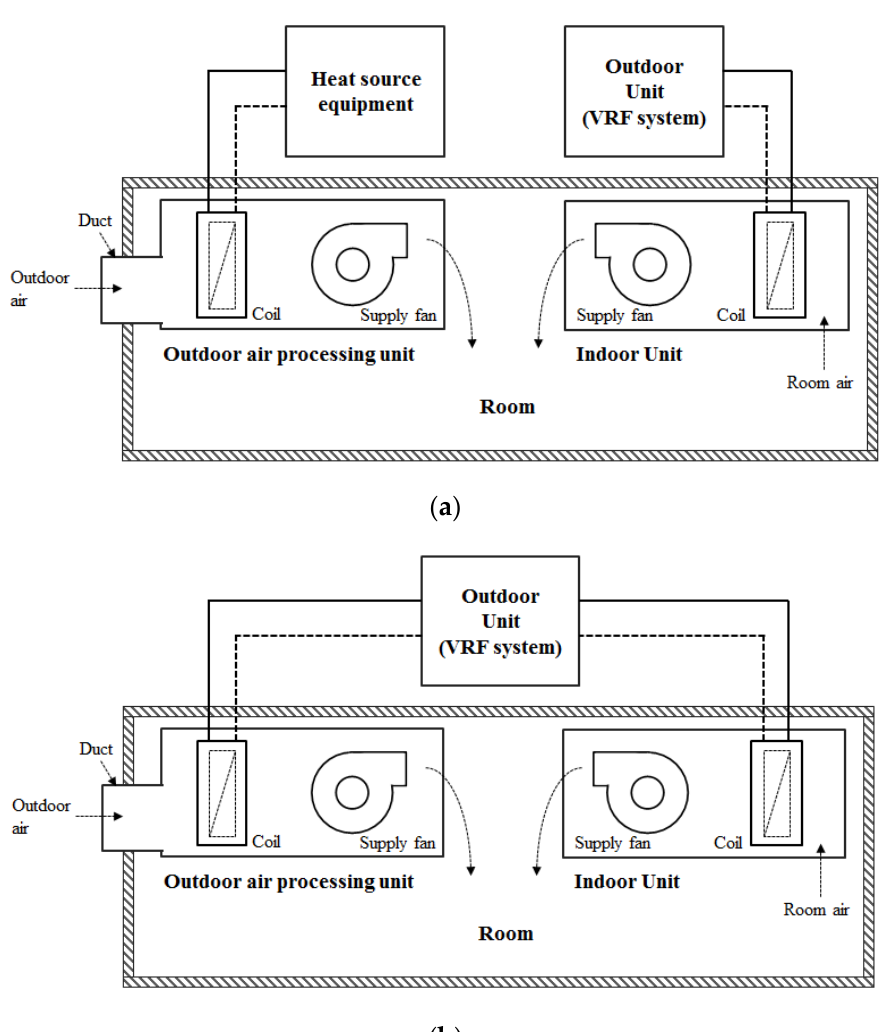
Figure 1. Schematic of OAP system. ( a ) Conventional OAP system; ( b ) Target VRF ‐ OAP system.